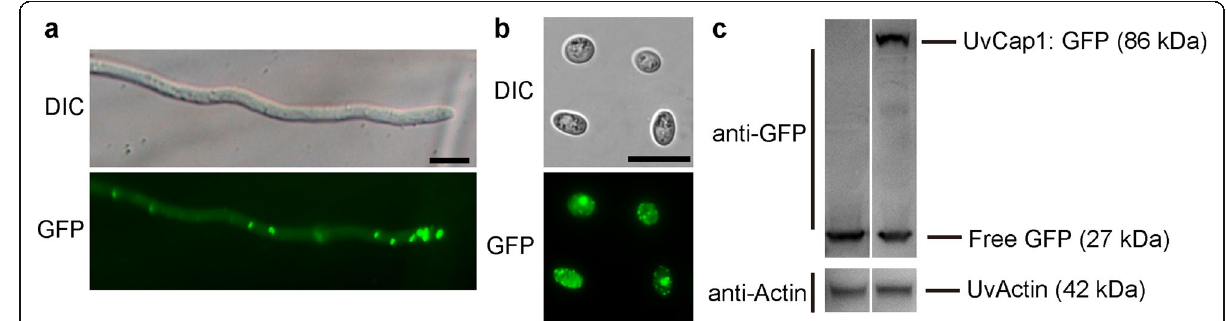
Fig. 8 Subcellular localization of UvCap1 in U. virens . a Location pattern of UvCap1 in the hyphae of U. virens . Bar, 10 μ m. b Location pattern of UvCap1 in the conidia of U. virens . Bar, 10 μ m. c Verification of UvCap1:GFP transformant by western blot using anti-GFP